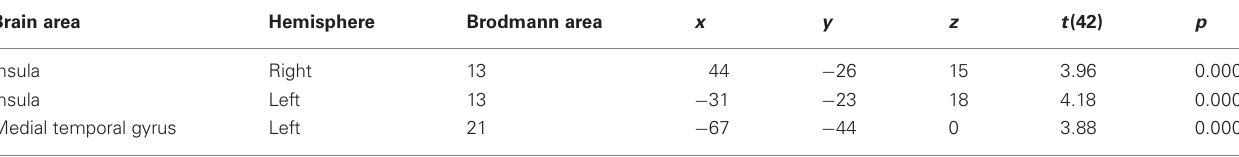
Table 3 |Activation changes for time compared to money during the “priming phase.”